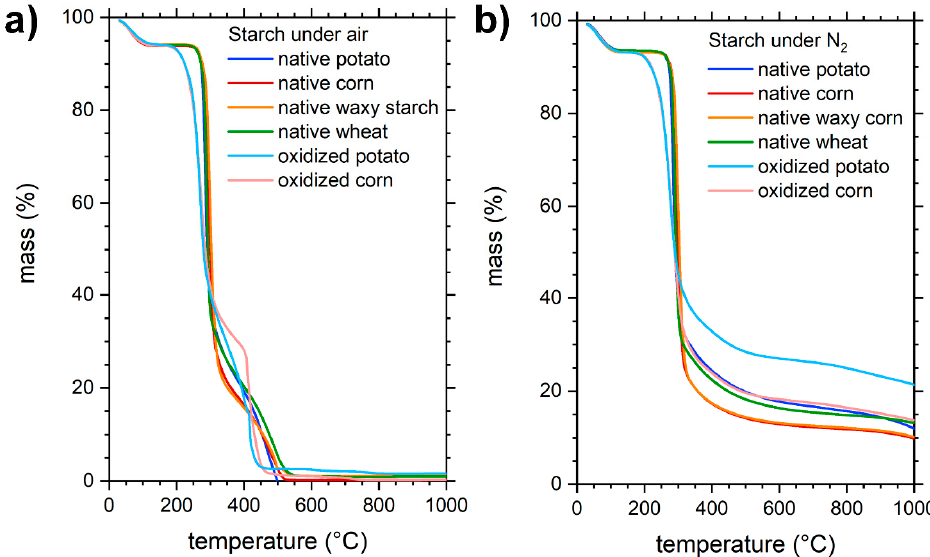
Figure 4. Thermogravimetric analysis ( a ) under air and ( b ) under nitrogen atmosphere of native potato starch (blue), native corn starch (red), native waxy corn starch (orange), native wheat starch (green), oxidized potato starch (light blue), and oxidized corn starch (pink).